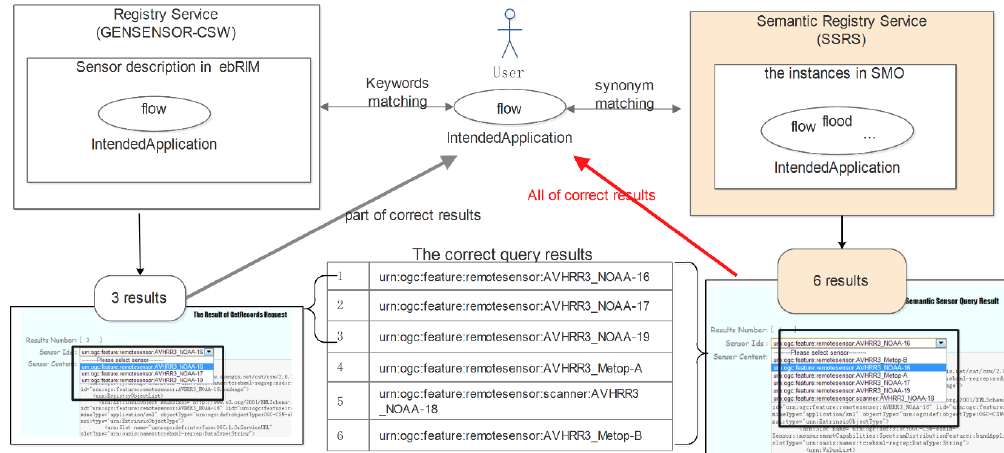
Figure 9. Comparison of a query in GEOSENSOR-CSW and in GEOSENSOR-SSRS.